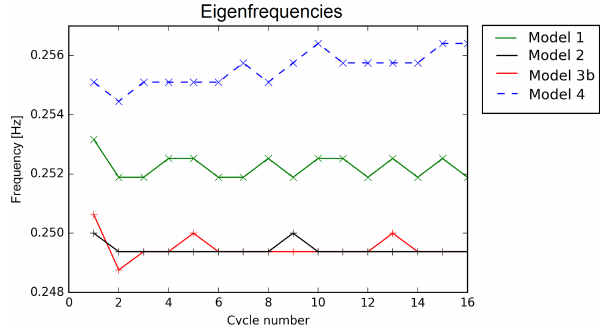
Figure 18. Eigenfrequencies for the foundation models.